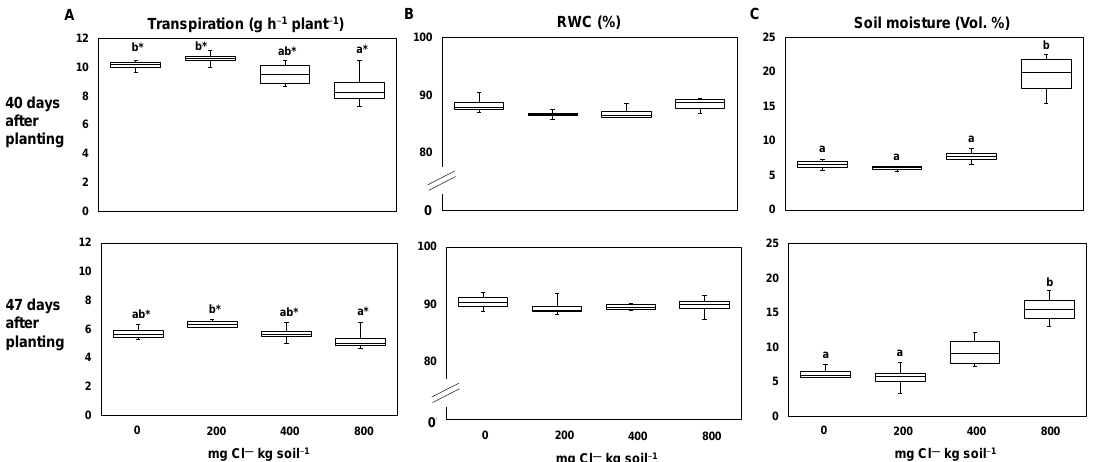
Agronomy 2021 , 11 , x FOR PEER REVIEW Figure 1. The effect of increasing chloride (Cl — )-fertilization on plant and soil water relations. Transpiration per plant ( A ), Figure 1. The effect of increasing chloride (Cl ― )-fertilization on plant and soil water relations. RWC ( B ), and soil moisture ( C ) at 40 days (above) and 47 days (below) after planting. Plants were treated with four Transpiration per plant ( A ), RWC ( B ), and soil moisture ( C ) at 40 days (above) and 47 days (be- Cl — supplies: 0 mg Cl — kg soil − 1 (control plants); 200 mg Cl — kg soil − 1 ; 400 mg Cl — kg soil − 1 ; 800 mg Cl — kg soil − 1 . Mean ± SE values; n = 4. Different lowercase letters indicate significant differences between Cl — treatments determined by multiple contrast test. No given lettermeans there wasno significant effect. Levels of significance: p < 0.05; * = p < 0.1.